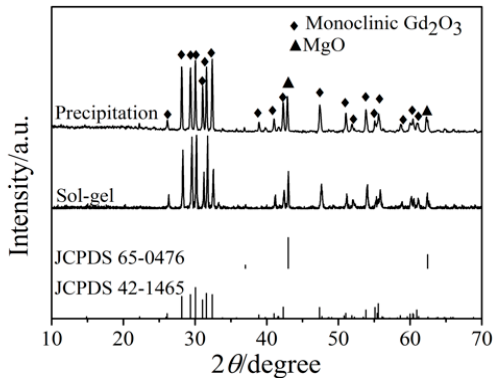
Figure 3. XRD patterns of the sintered nanocomposite ceramics with nanocomposite powders from different methods.